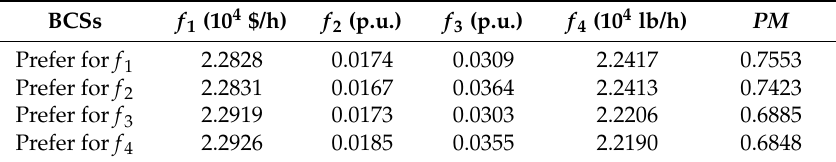
Table 4. Best compromise solutions (BCSs) of IEEE 118-bus system.